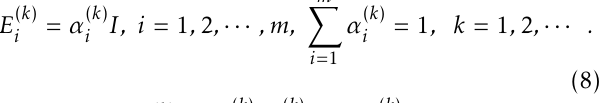
Algorithm 1. (SMTS) The non-stationary parallel multisplitting two-stage iterative methods with self- adaptive weighting